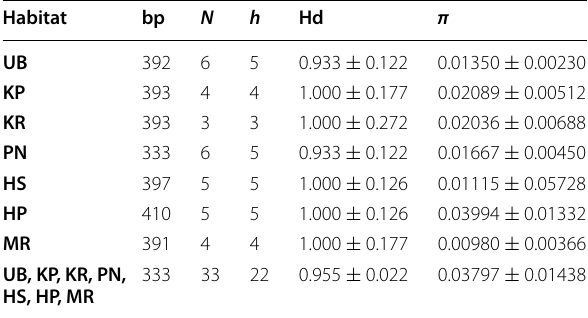
Table 3 Genetic variation of Cynopterus brachyotis from seven habitats on Java island based on mitochondrial DNA D-loop